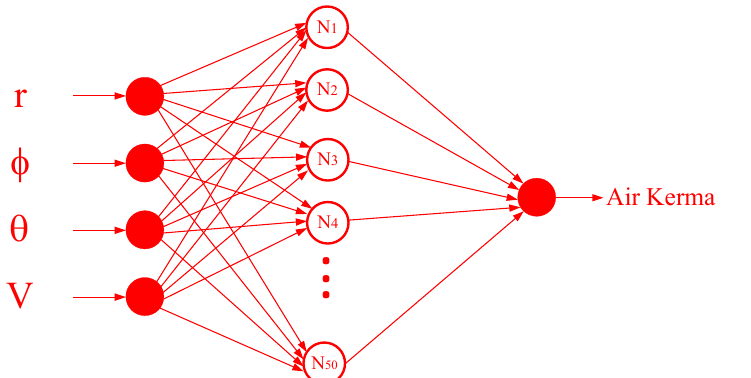
Figure 4. Structure of trained neural network.